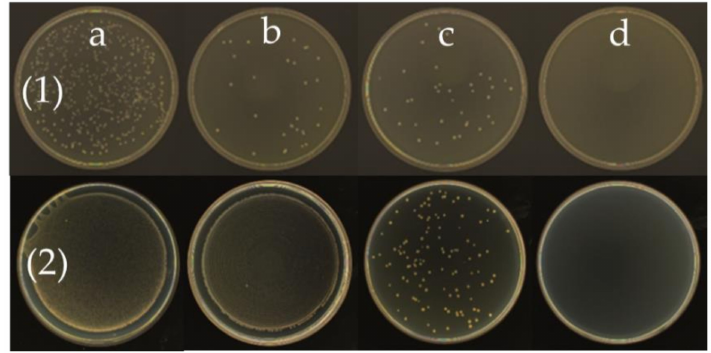
Figure 9. Antibacterial performance of ABS / octyl-QDED. Bacteria: (1) S. aureus , (2) E. coli ; composites: ( a ) ABS; ( b ) 1, ( c ) 2, ( d )